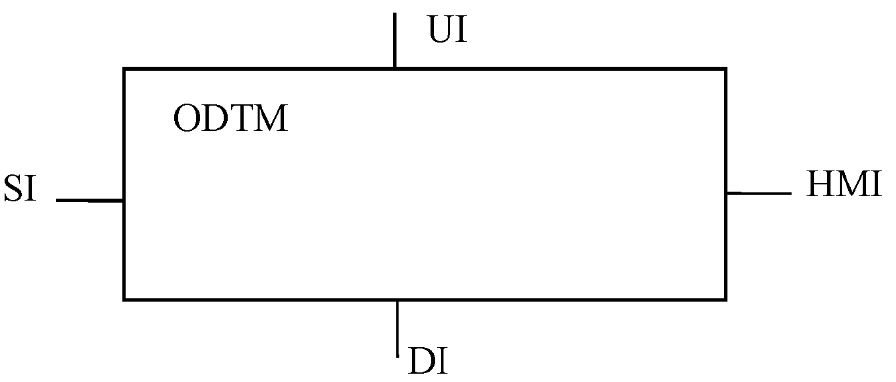
Figure 2. ODTM structure.